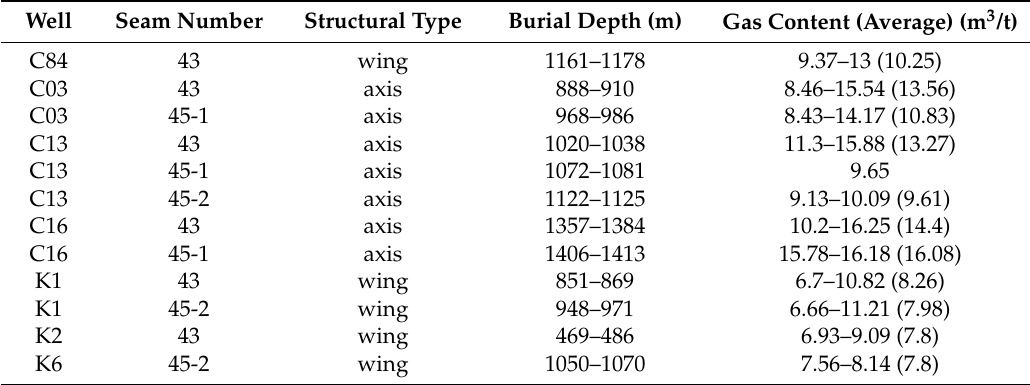
Table 5. Gas content of CBM wells in the